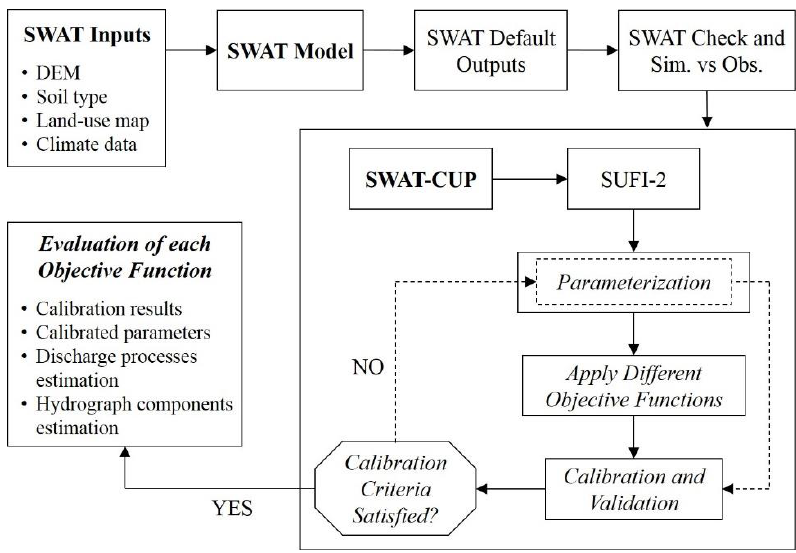
Figure 2. Workflow diagram.